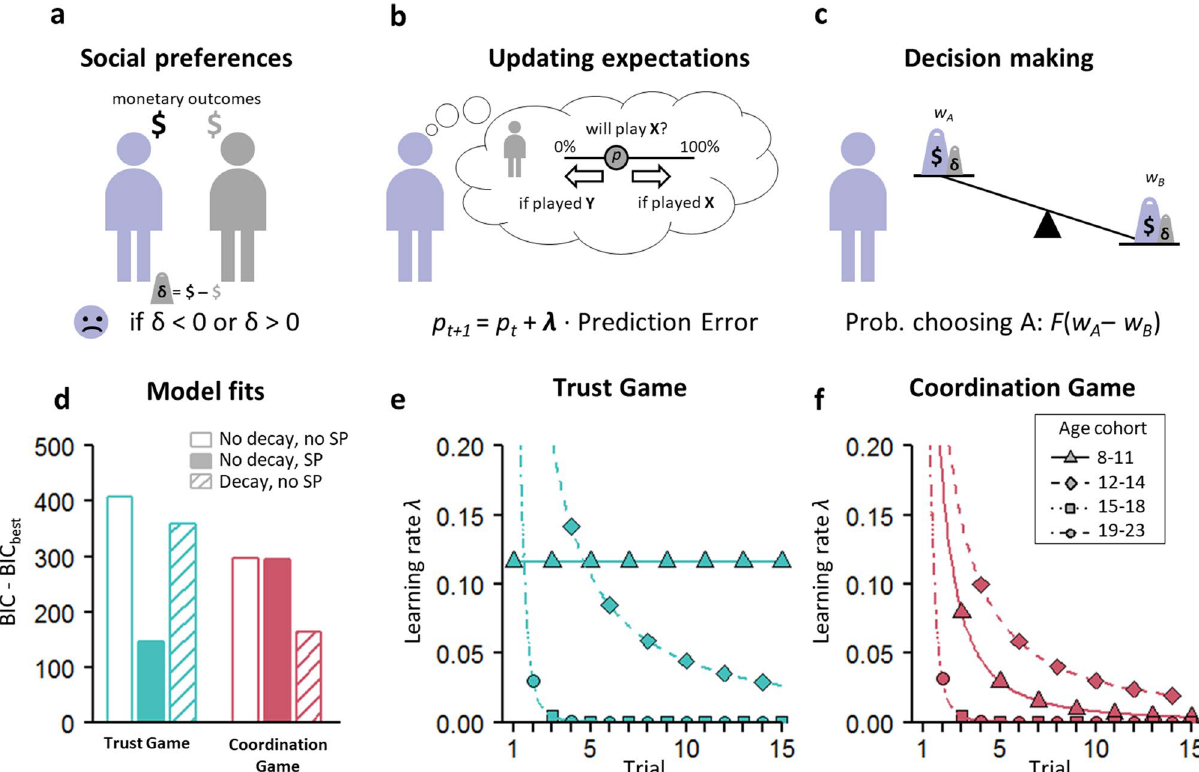
Figure 4. Model of reinforcement learning with social preferences. ( a ) Individuals acquire monetary payoffs ($) from interactions in the games ( cf . Figure 1). How they subjectively value each outcome can be influenced by their social preferences (Fehr & Schmidt, 1999), whose impact is proportional to the differences in payoff between interaction partners (δ). ( b ) Over the course of the games, individuals update their expectations ( p ) about the behaviour of the other players. The extent of updating is proportional to the prediction error (i.e., the difference between the expected and actual outcome) and learning rate λ 71 . ( c ) The probability that an